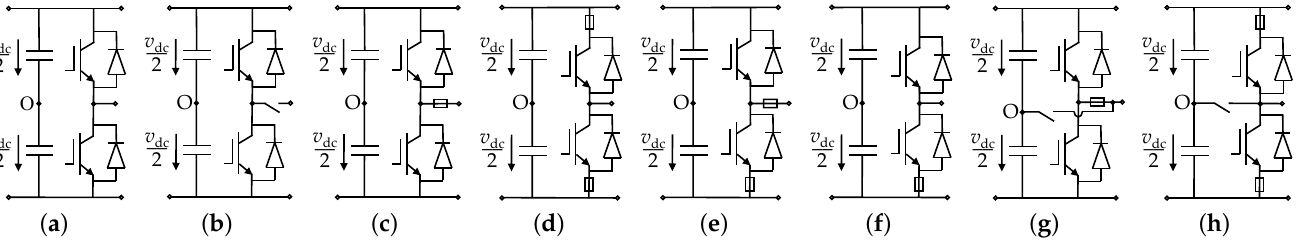
Figure 15. Schematic of two-level VSC dc link and an arbitrary leg [343]. ( a ) Without extra elements. ( b ) With a bidirectional switch per line. ( c ) With a fuse per line. ( d ) With a fuse per IGBT. ( e ) With a fuse per line and leg. ( f ) With a fuse per leg. ( g ) With a fuse per line and a bidirectional switch to connect to the dc-link midpoint O. ( h ) With a fuse per IGBT and a bidirectional switch to connect to the dc-link midpoint